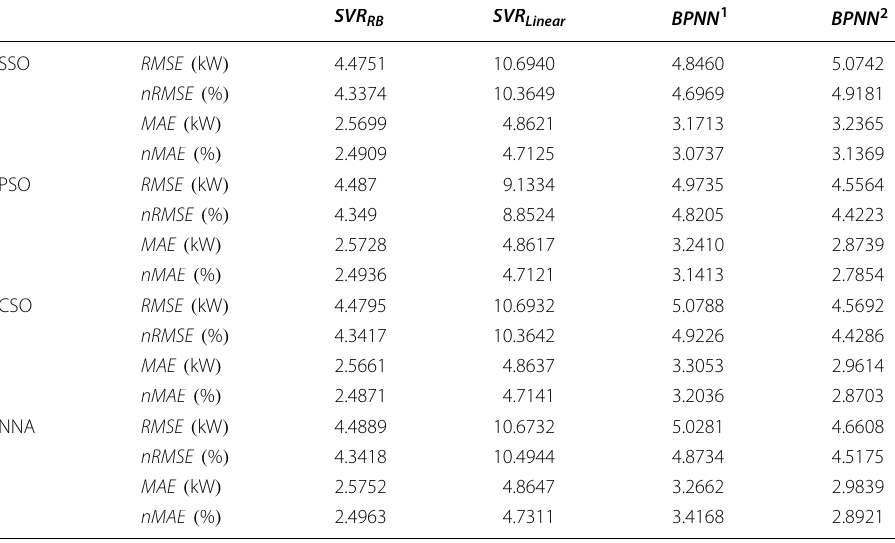
Table 3 Statistical errors of the best-proposed forecasting models using SSO , PSO , CSO and NNA